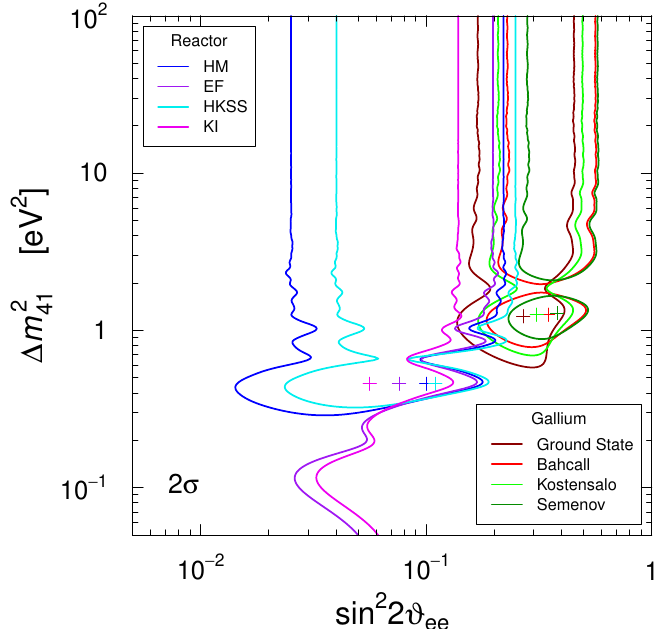
Figure 2. Contours delimiting the 2 σ allowed regions in the ( sin 2 2 ϑ ee , ∆ m 2 the Gallium data with different cross sections compared with those obtained in ref. [14] from the analysis of short-baseline reactor rate data. The best-fit points are indicated by